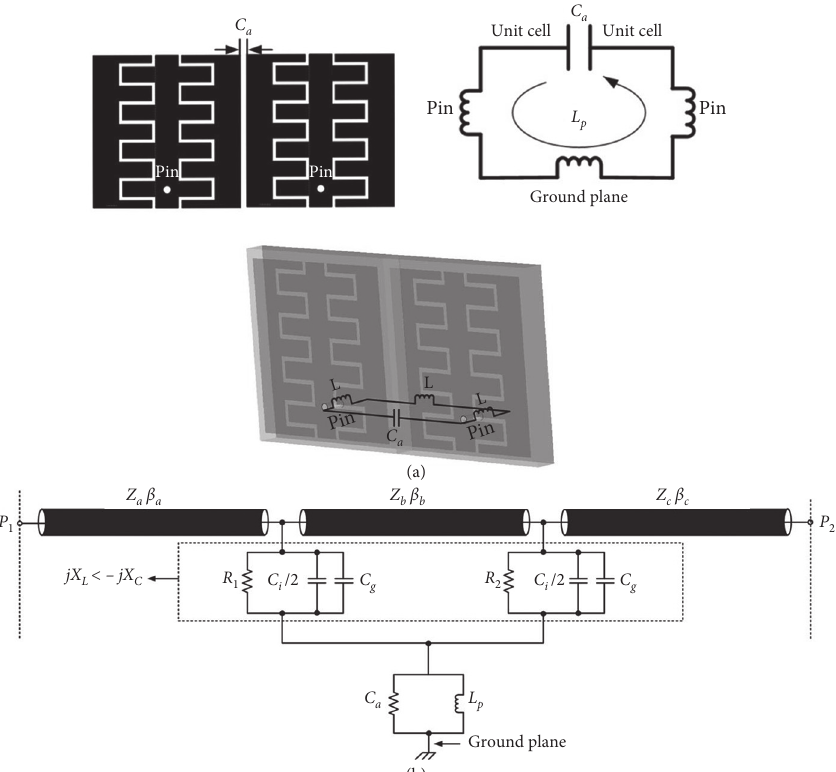
Figure 3: (a) The structure of ICPW-EBG unit cell and capacitance in array EBG. (b) Equivalence circuit of ICPW-EBG unit